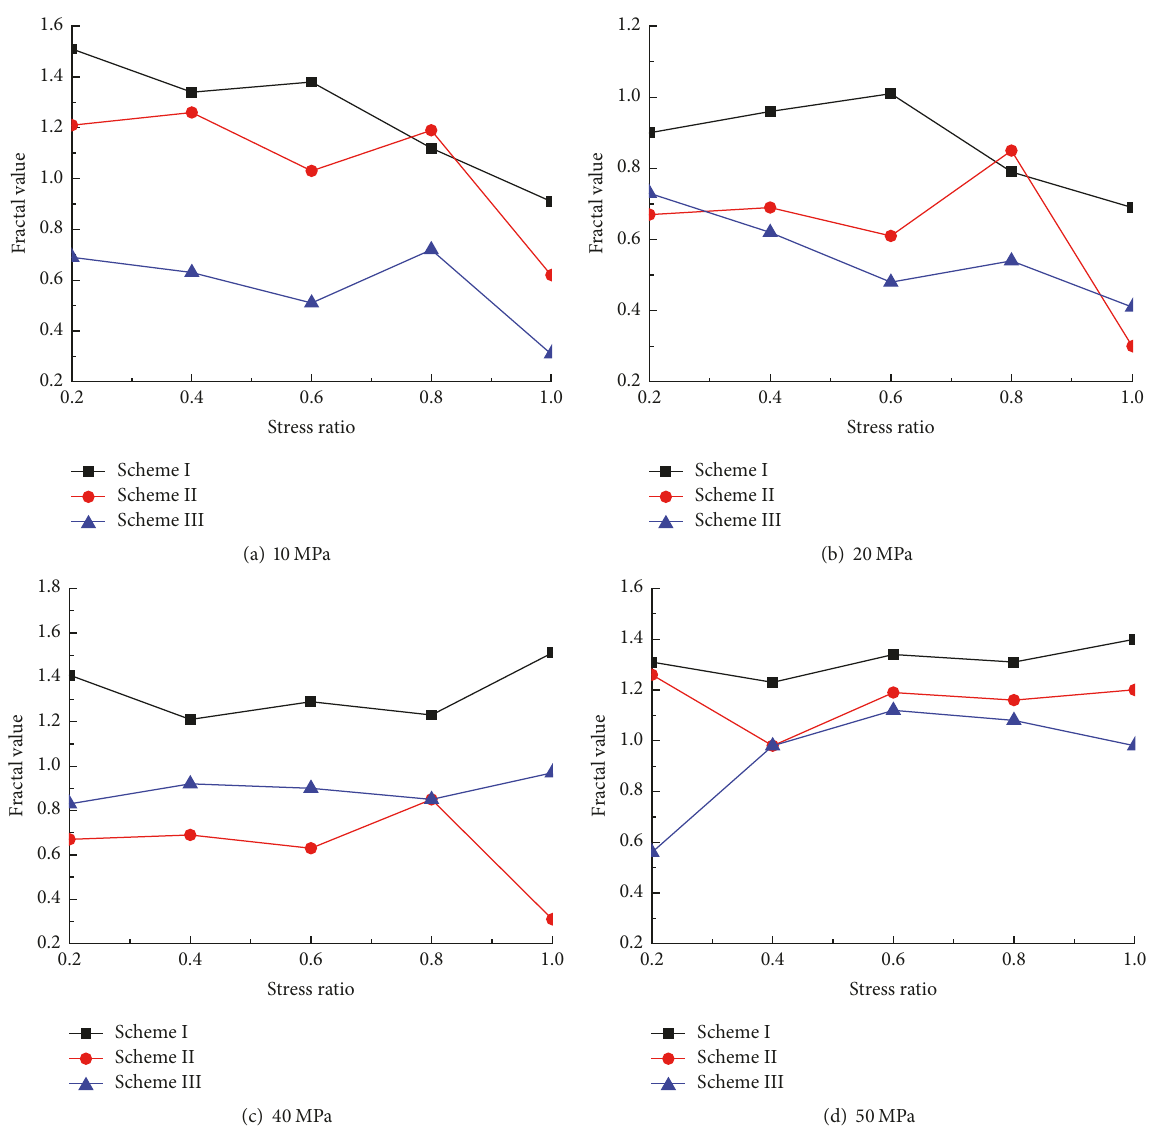
Figure 6: Fractal values of AE of sandstone samples under different stress paths (stress